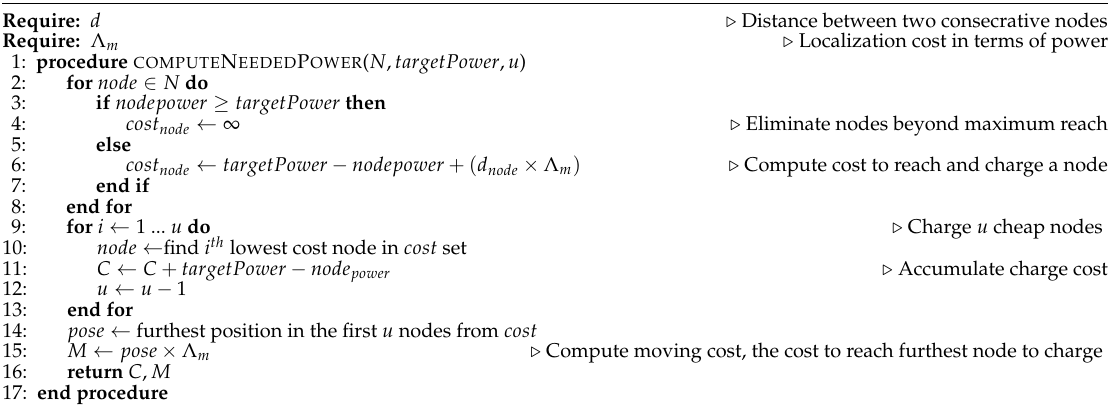
Algorithm 7 Compute Needed Power to Charge and Move Given Nodes.